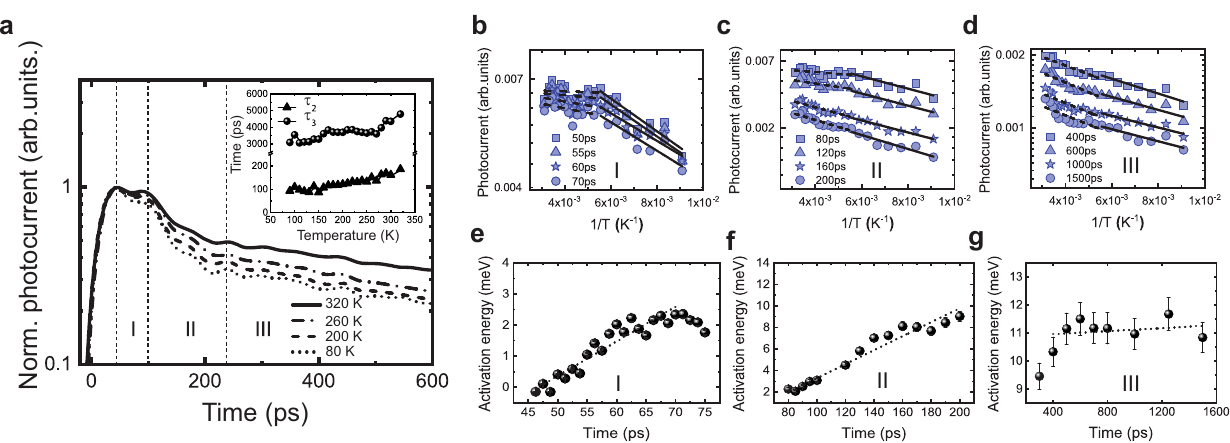
Fig. 2 Ultrafast photocurrent dependence on temperature. a The normalized ultrafast photocurrent decay at various temperatures. The inset is decay constants dependence with temperature of region II and region III. Arrhenius plots at various times of region I ( b ), region II ( c ), and region III ( d ). e – g The corresponding thermal activation energy dependence in the 180 – 320 K temperature range